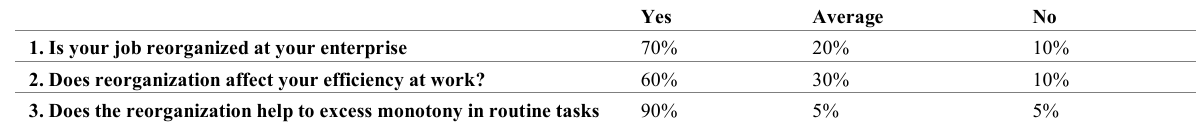
Table 2: Using the reorganization process and impacting the efficiency of RH